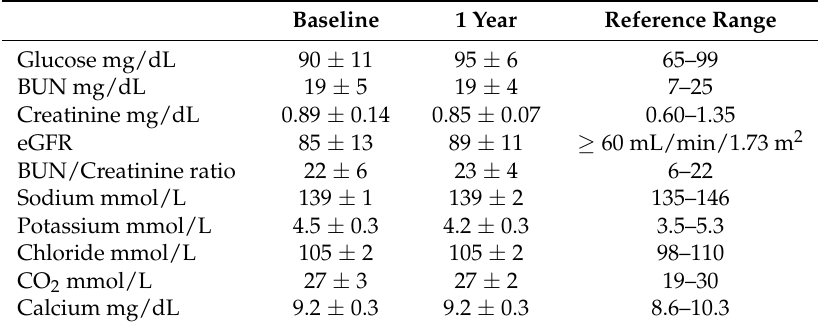
Table 3. Basic metabolic